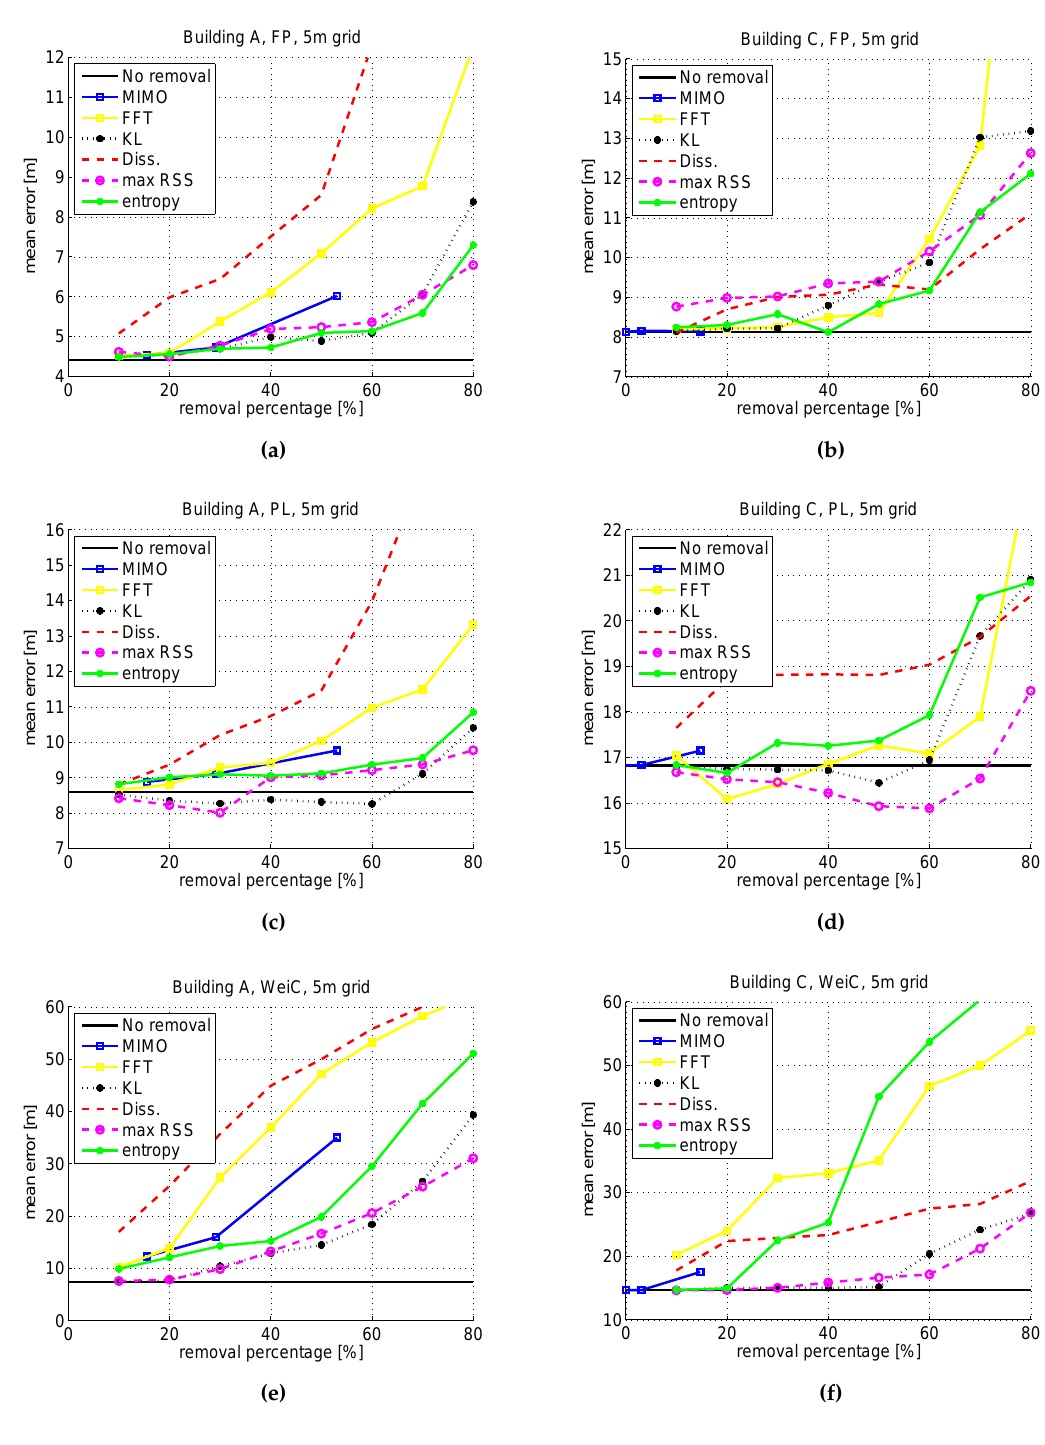
Figure 2. Average positioning error [m] for all AP selection criteria. FP, PL and WeiC positioning approaches. Building A ( a , c , e ) and building C ( b , d , f ) with 5 m horizontal grid